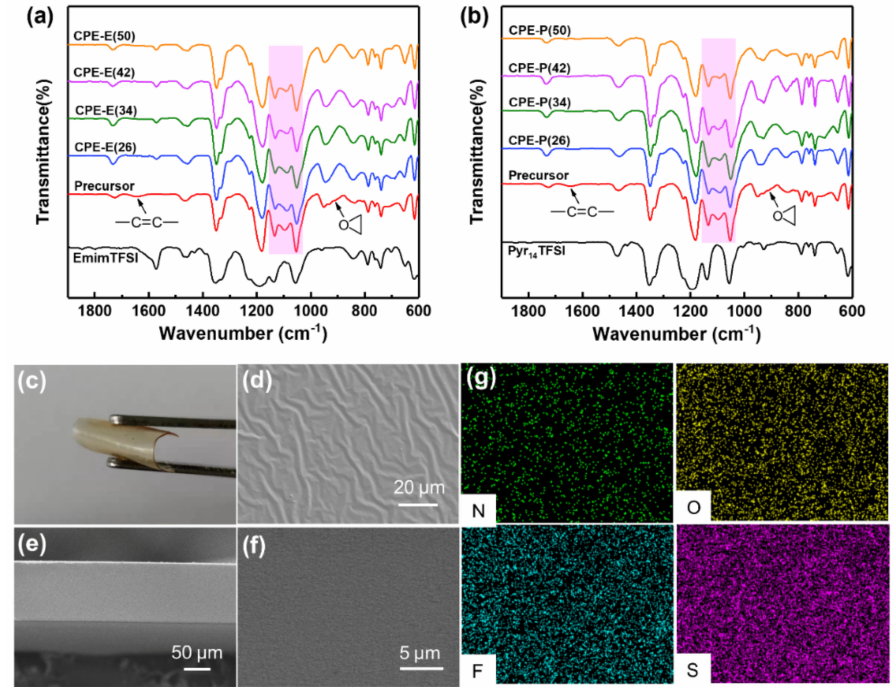
Figure 1. The FTIR spectra between 2000 and 600 cm − 1 of the ionic liquids, precursors, and different CPEs ( a , b ). The photograph ( c ), surface SEM image ( d ), and cross-section SEM images ( e , f ) of the